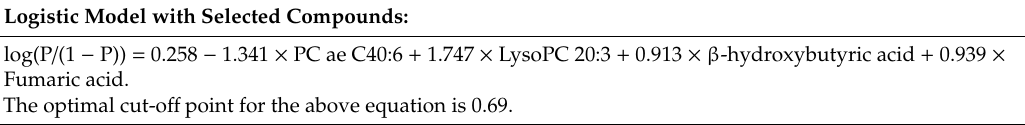
Table 2. Logistic regression based optimal model for stage I NSCLC detection: metabolites only. Logistic Model with Selected Compounds: